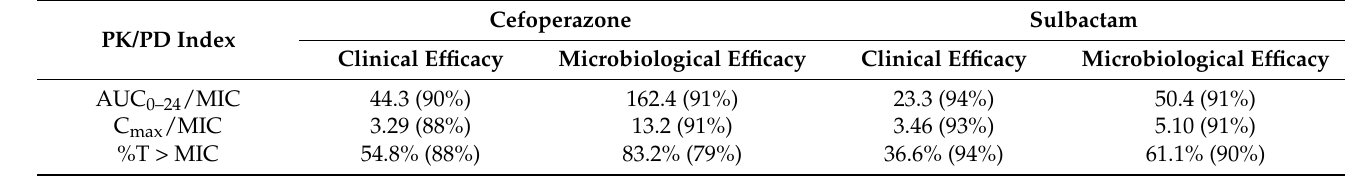
Figure 2. Correlation between the PK/PD index of cefoperazone (Panel A – C ) or sulbactam (panel D – F ) and clinical efficacy. Y-axis means the probability of successful clinical efficacy. Table 3. PK/PD target cefoperazone and sulbactam against infection by Ab.